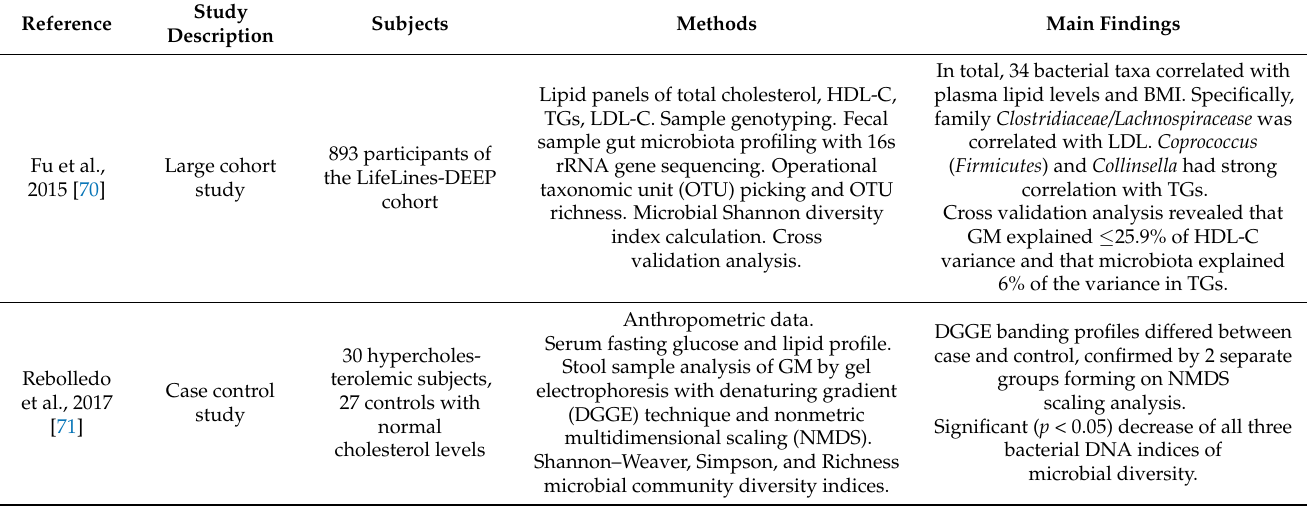
Table 1. Gut microbiota in relation to